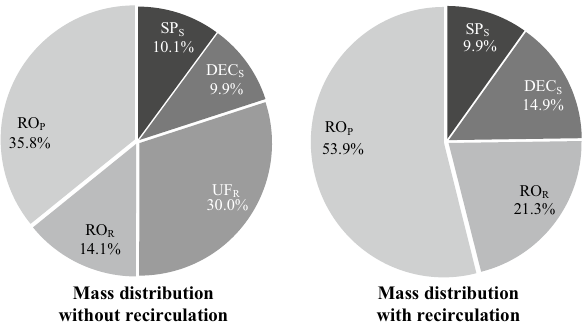
Fig. 6 Mass distribution of the membrane-based nutrient recovery; left: without and right: with recirculation of the UF retentate; the sum of SP S and DEC S forms an organic N/P-fertiliser, RO R represents a liquid N/K-fertiliser and RO P dischargeable water